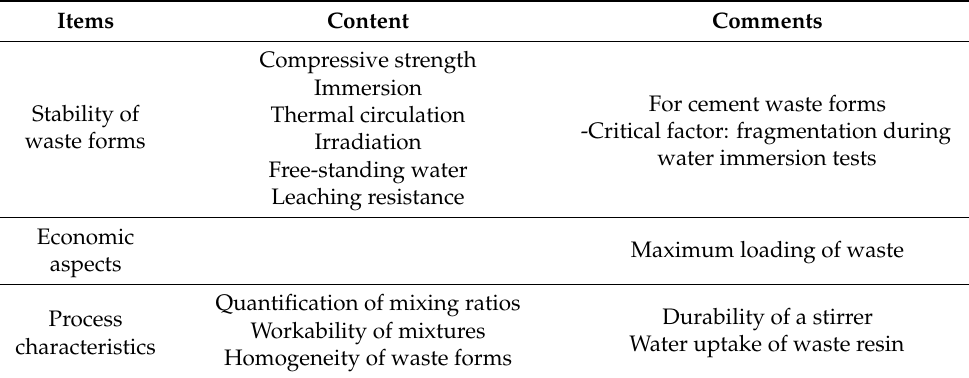
Table 3. Factors to consider when operating a solidification process facility.